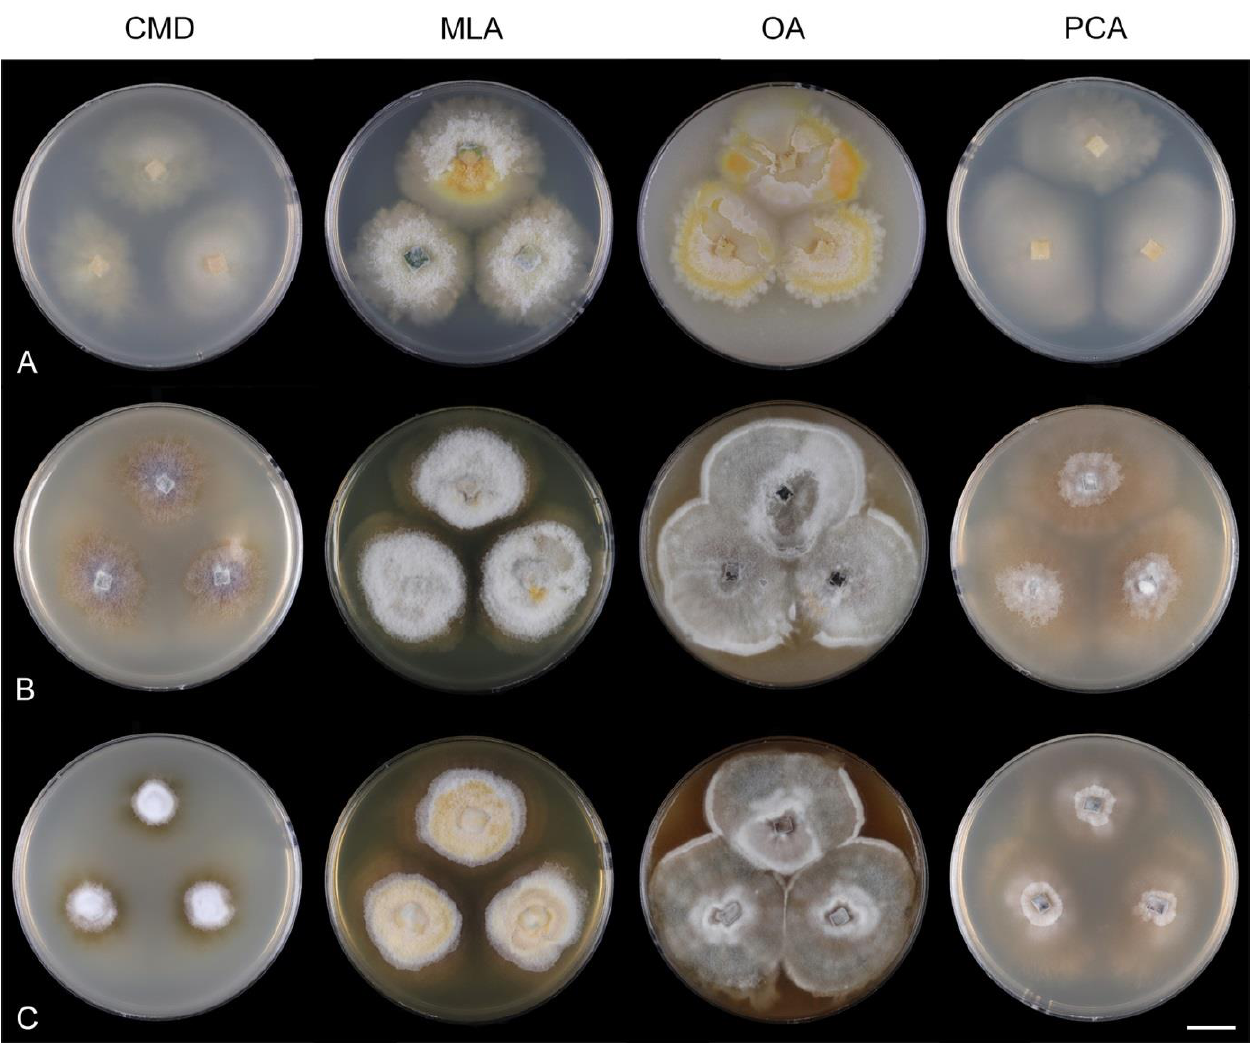
Figure 8. Colony morphology of Multiguttulispora after 4 weeks. ( A ) M. dimorpha CBS 140002 ( B ) M. triseptata IMI 353690 ( C ) M. triseptata CBS 487.92. Scale bar: ( A – C ) 1 cm.